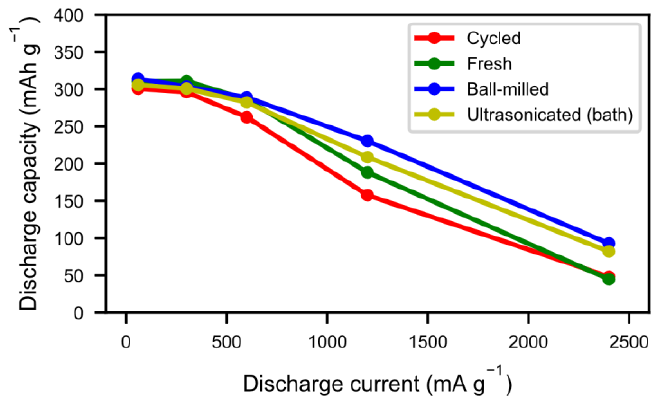
Figure 9. The discharge capacity at 60 mA g −1 , 300 mA g −1 , 600 mA g −1 , 1200 mA g −1 , and 2400 mA g −1 for fresh material, cycled material, ball-milled material, and bath-ultrasonicated material.